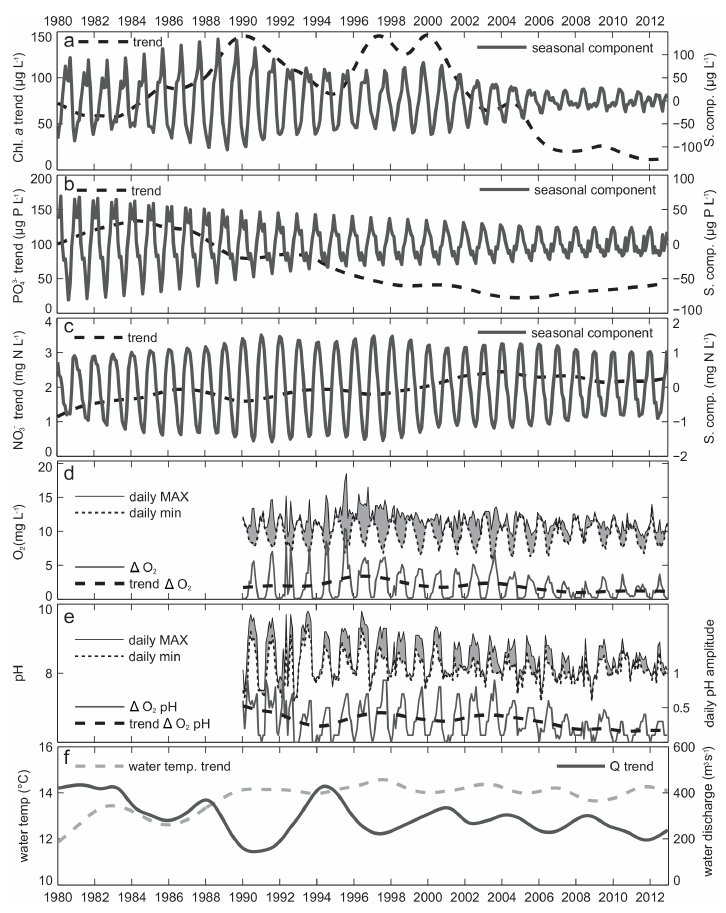
Figure 4. Trends and seasonal components at station 18 of Chl a (a) , phosphate (b) and nitrate (c) . Corresponding time series of monthly medians of both daily min and max of O 2 (d) and pH (e) and their amplitude dynamics at station 19 (i.e., (cid:49) O 2 and (cid:49) pH). Water temperature trend at station 19 (f) and discharge trend at station 15 beginning in